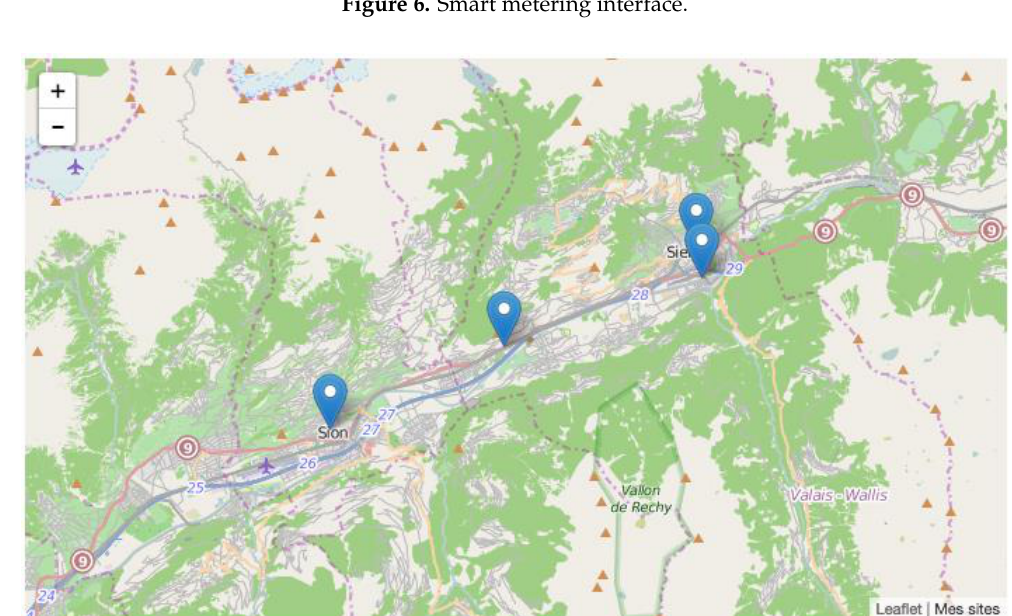
Figure 6. Smart metering interface.